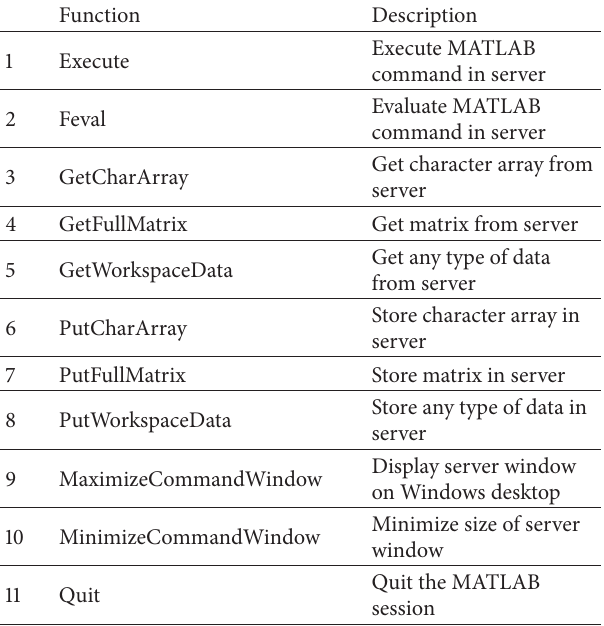
Table 2: MATLAB automation server set of